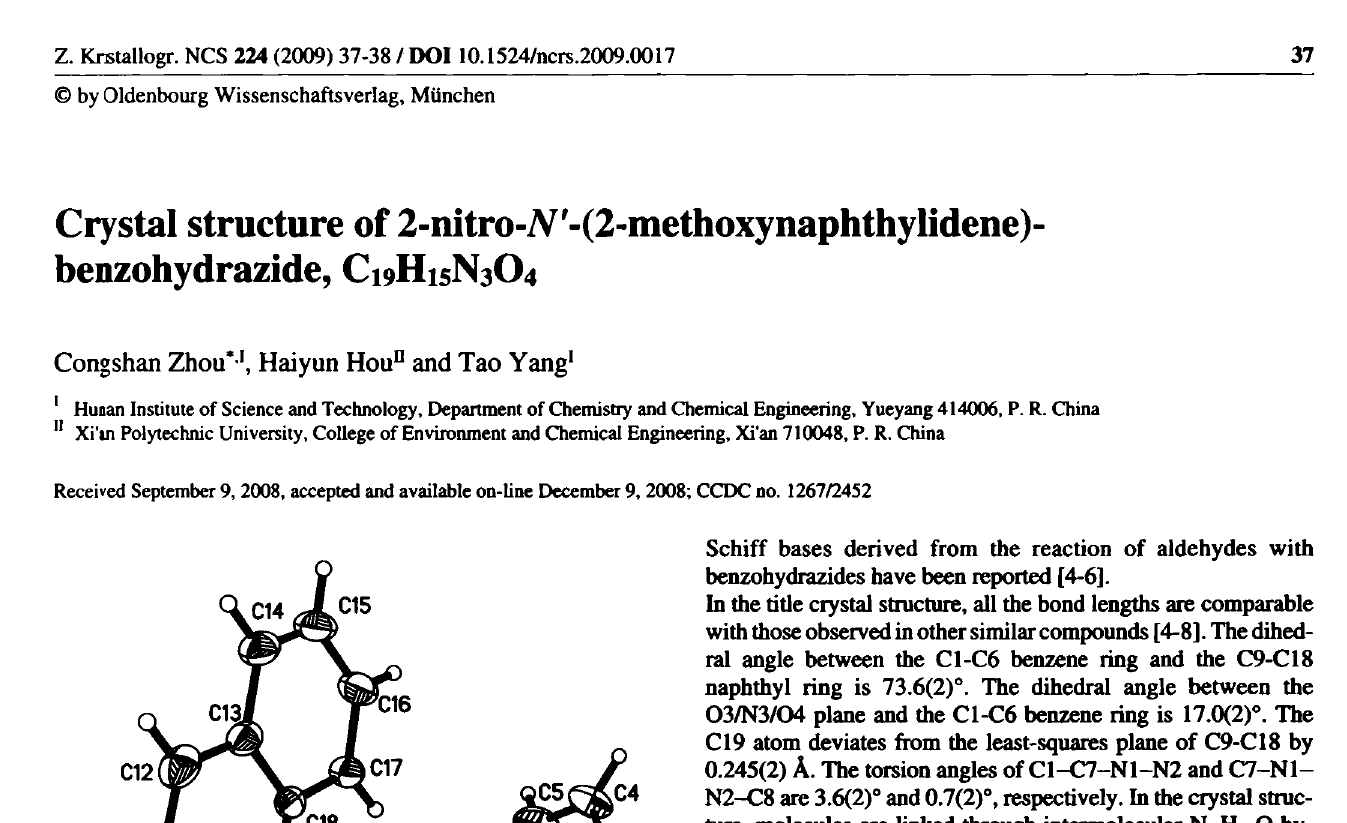
Table 2. Atomic coordinates and displacement parameters (in Â 2